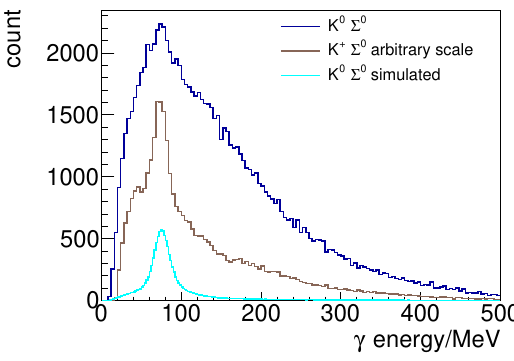
Figure 4. Energy spectrum of the Σ 0 decay photon for real and simulated data. To prove the technique is working correctly the channel K + Σ 0 is studied.